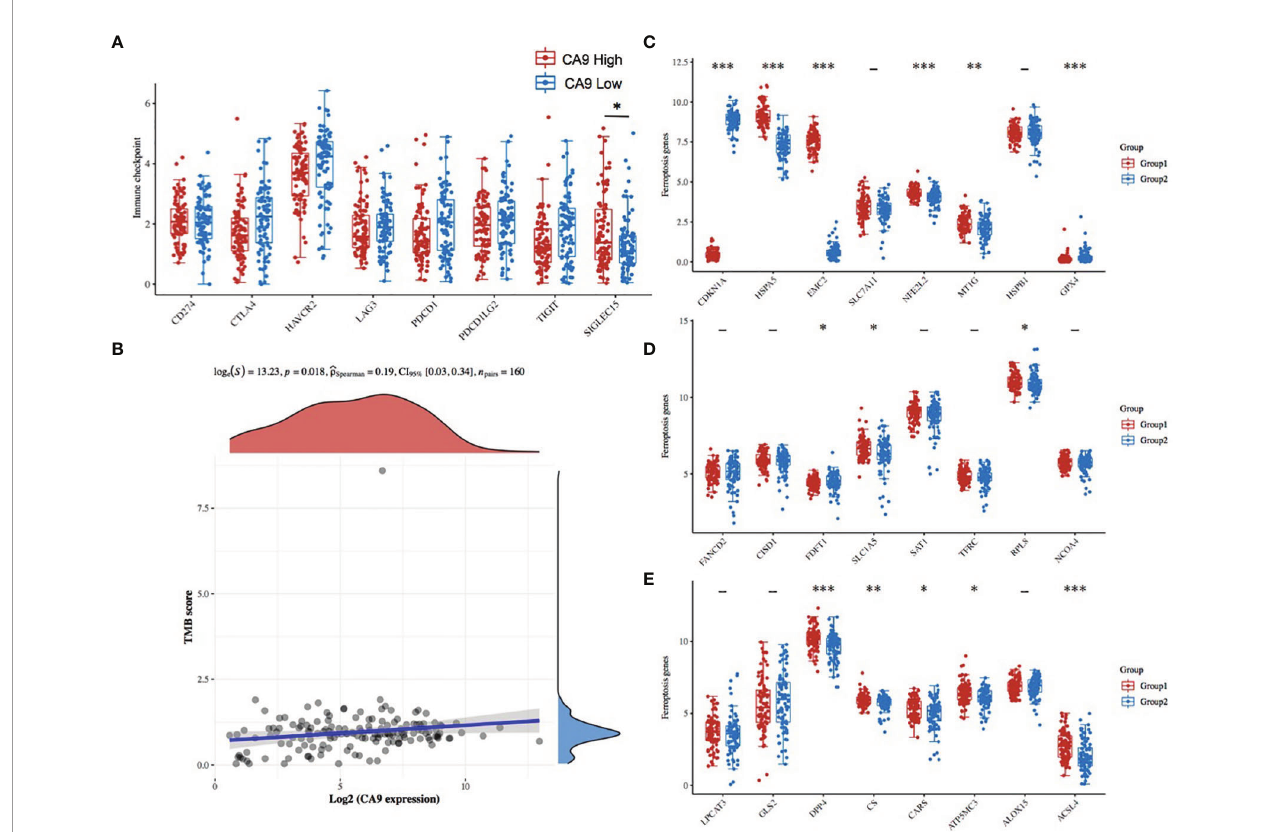
FIGURE 8 | The association between CA9 expression and immune checkpoints, tumor mutation burden and ferroptosis-related genes from TCGA dataset. (A) Comparison of immune checkpoints expression among CA9-high tumor tissues and CA9-low tumor tissues. (B) Correlation analysis of CA9 expression and TMB. The horizontal axis in the fi gure represents the expression distribution of the gene, and the ordinate is the expression distribution of the TMB score. The density curve on the right represents the distribution trend of the TMB score; the upper density curve represents the distribution trend of the gene; the top side The value represents the correlation p value, correlation coef fi cient and correlation calculation method. (C-E) . The expression distribution of Ferroptosis-related mRNA in CA9- high and CA9-low tumor tissues, where the horizontal axis represents different mRNA, the vertical axis represents the mRNA expression distribution, where different colors represent different groups, and the upper left corner represents the signi fi cance p-value test method.Asterisks represent levels of signi fi cance *p<0.05, **p<0.01,